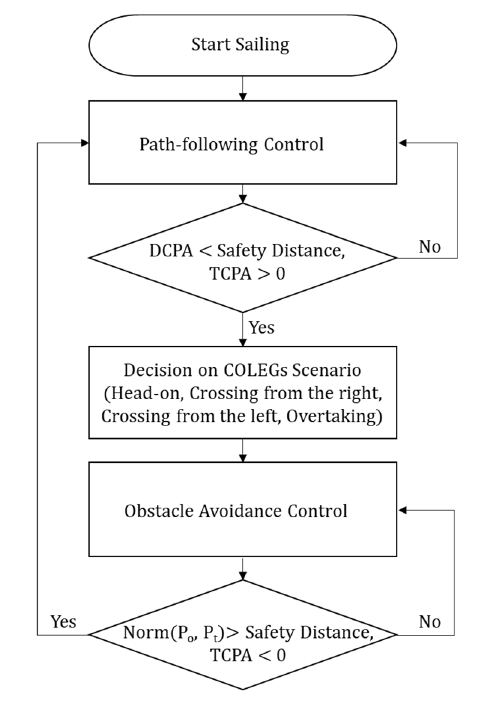
Figure 5. Flowchart of USV control.